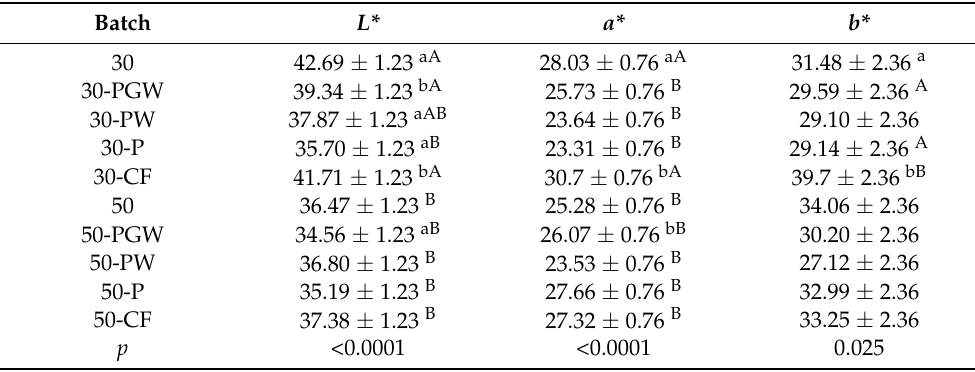
Table 3. Color parameters of the ten products (mean ± SE) (1)